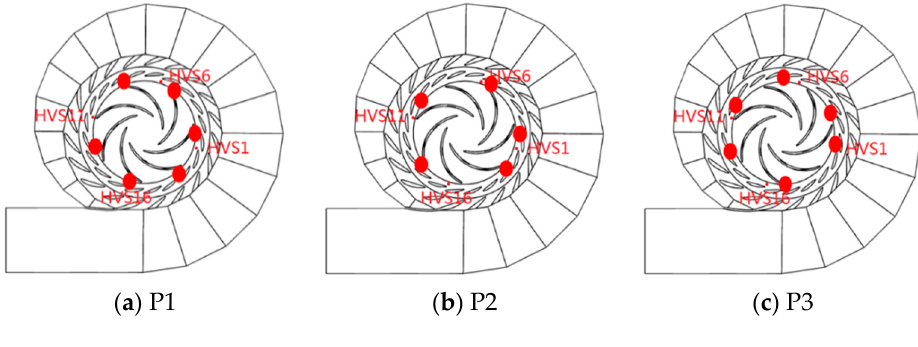
Figure 21. Peak value positions at BPF. Table 6. Shift angle of peak value when the mass flow rate decreased with 9 blades.